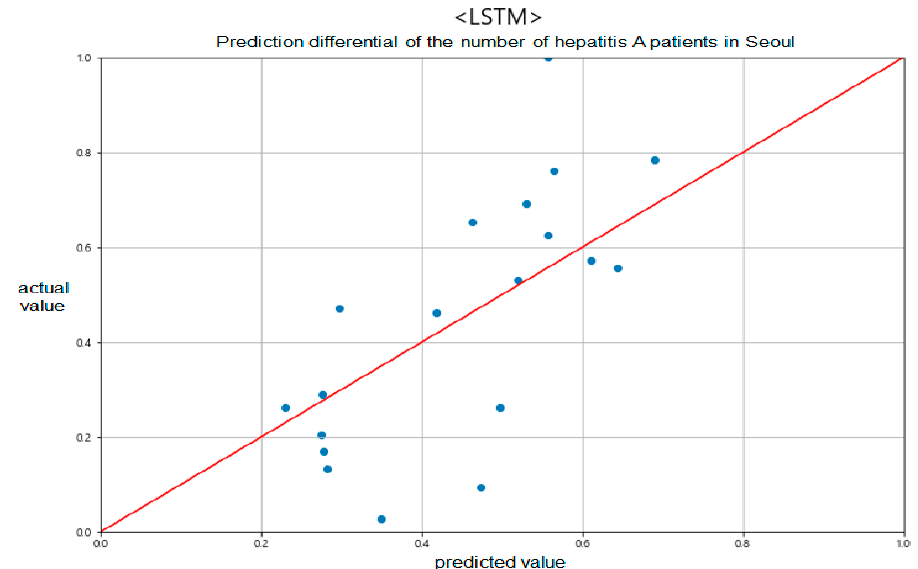
Figure 9. Prediction differential of the number of hepatitis A patients in Seoul between predicted and actual values.